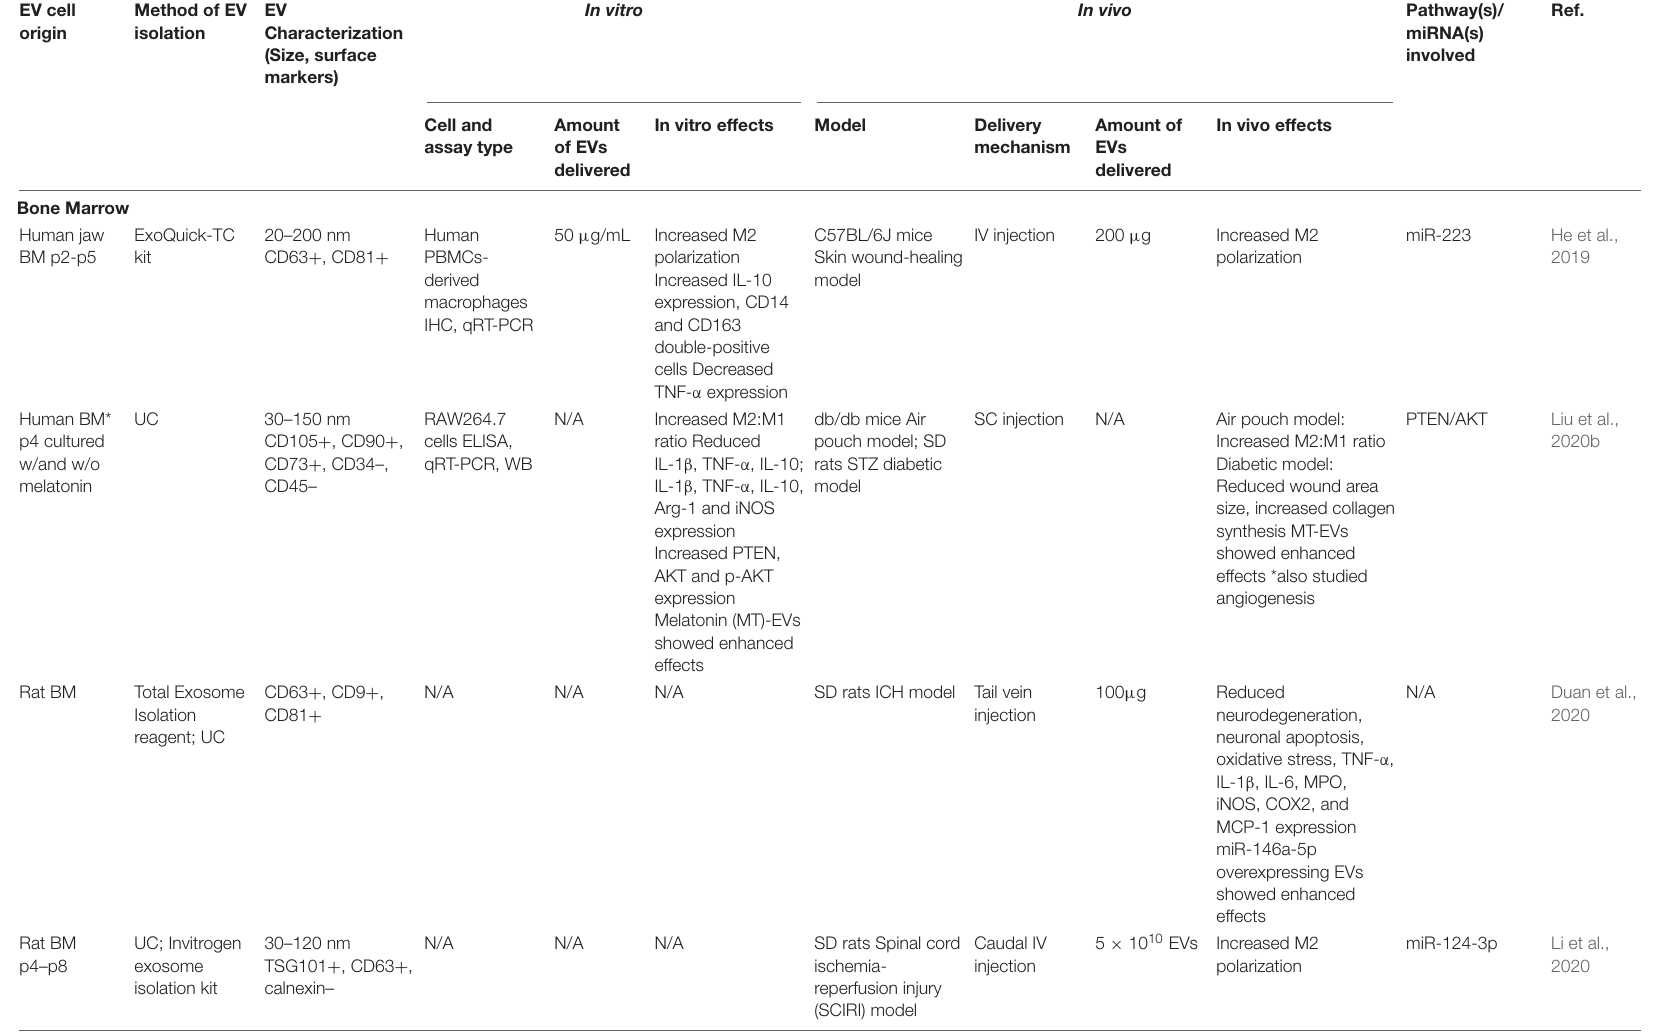
TABLE 3 | Preclinical studies employing BMMSC- and ADMSC-derived EVs to induce macrophage